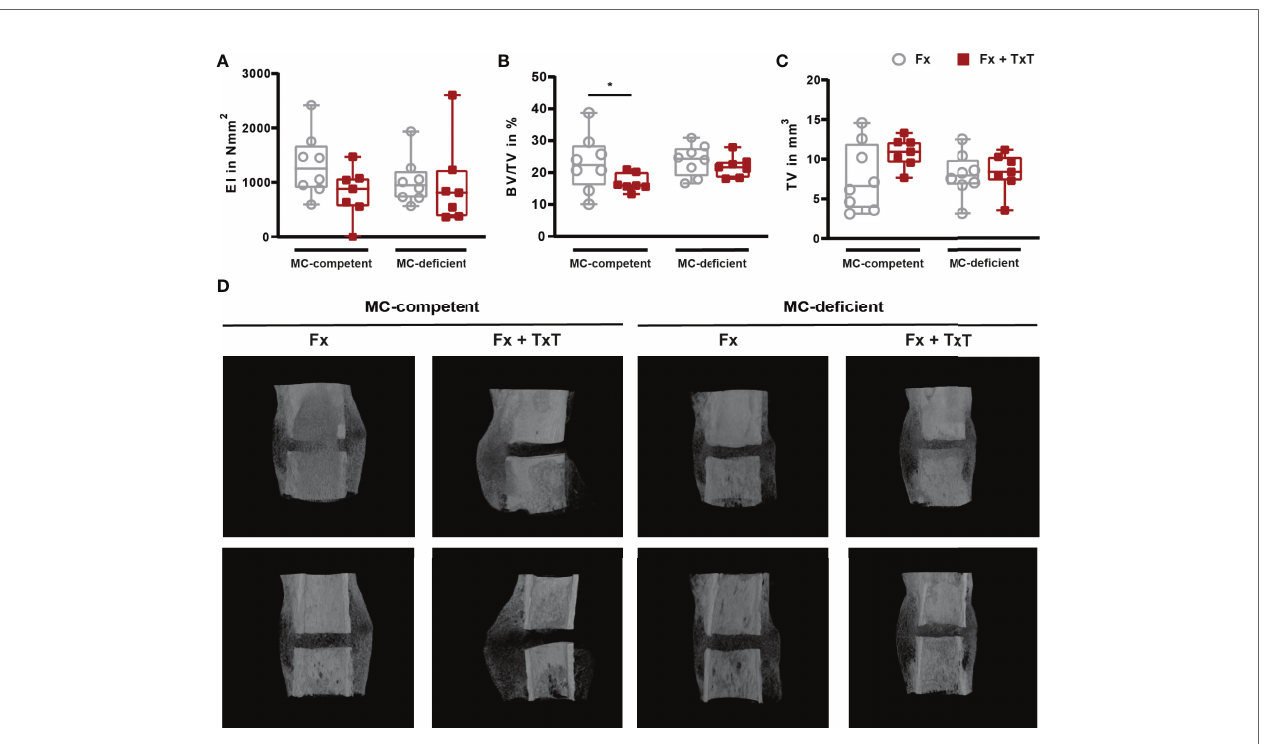
FIGURE 6 | Biomechanical and µCT analyses from fractured femurs of mast cell (MC)-competent and MC-de fi cient mice 21 d after isolated fracture (Fx) and combined fracture and thoracic trauma (Fx + TxT). (A) Bending stiffness (EI) of fractured femurs. (B) Bone volume to tissue volume (BV/TV) in the periosteal fracture callus. (C) Tissue volume (TV) of the periosteal fracture callus. (D) Representative images from µCT three-dimensional reconstructions of the fracture area recorded at similar settings. Gray boxes represent Fx mice, red boxes represent Fx + TxT mice. Data are shown as box-and-whisker plots (with median and interquartile range) from maximum to minimum, showing all data points. *p<0.05. The p values were determined using one-way ANOVA with post hoc Fisher ’ s